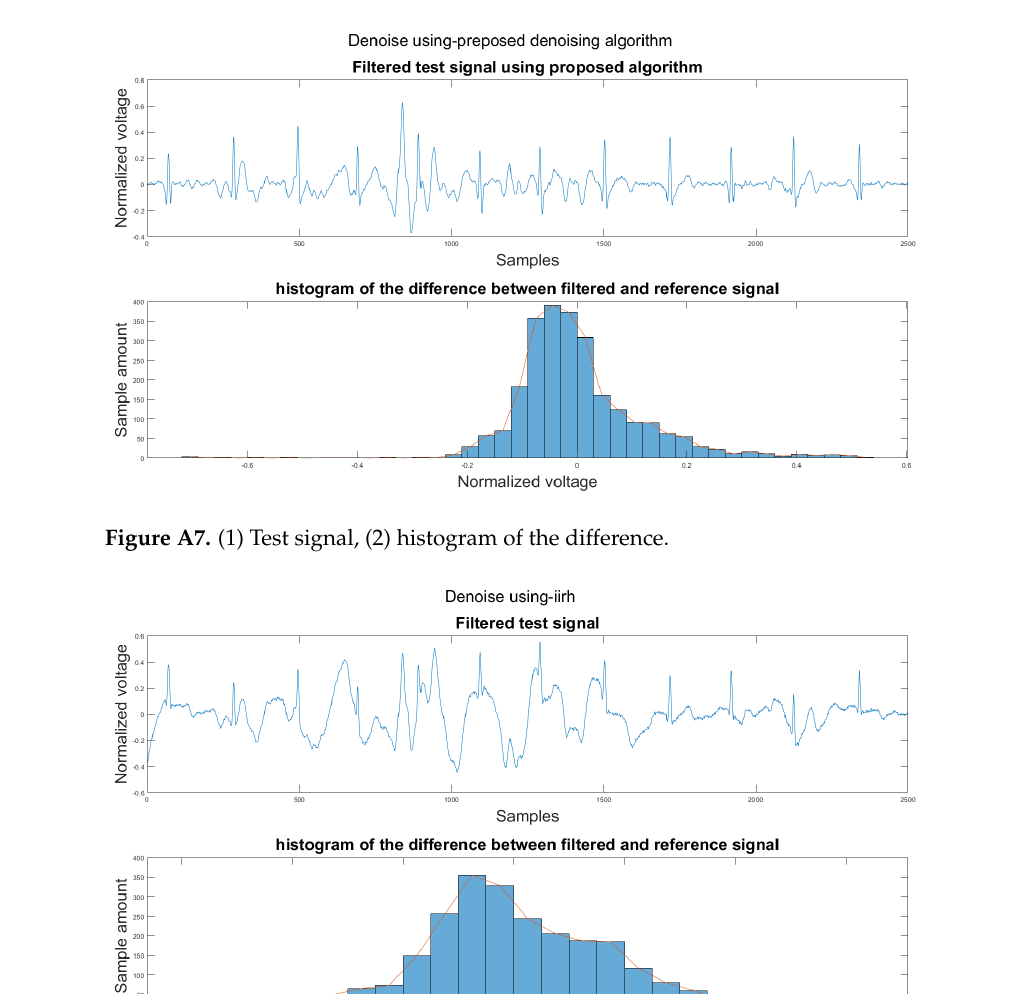
Figure A6. (1) Test signal, (2) histogram of the difference.